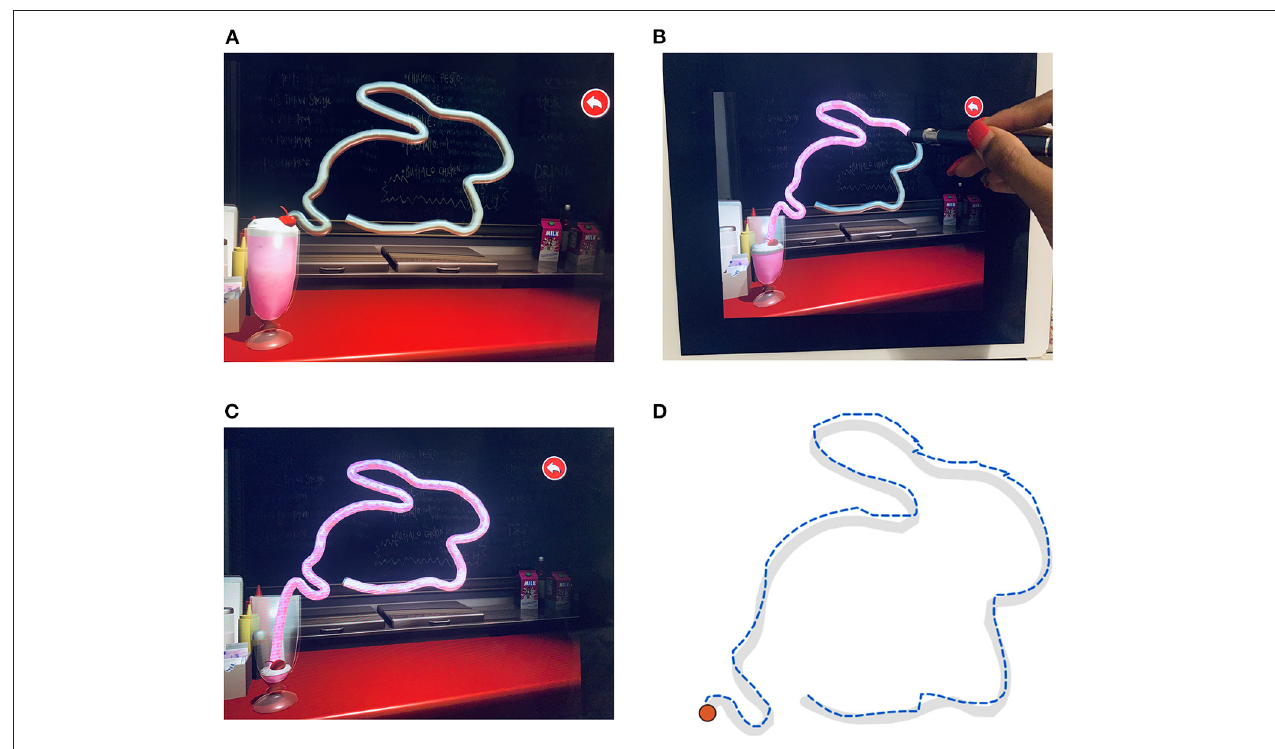
FIGURE 2 | The UNSW Lee-Ryan Eye Hand Coordination Test (SLURP) using the rabbit shape. (A) Geometric shape of the rabbit prior to start of task. Timing is initiated when the participant touches the red cherry spot at the top of the glass carrying the milkshake of panel. (B) Example of Rabbit trace in progress with the stylus iPad pen. Note that the milk shake enters the straw and defines the path that has been correctly traced up to that time. (C) Completed trace of Rabbit shape. (D) Example of a patient’s trace of the rabbit shape. The desired trace path is shown in gray. The blue dashed line identifies the participant’s trace with displacement errors displayed as contour